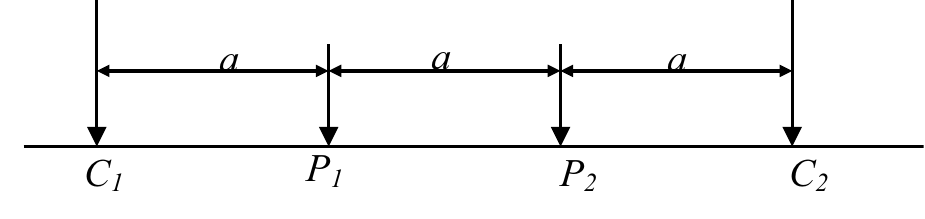
Fig. 2 Wenner electrode